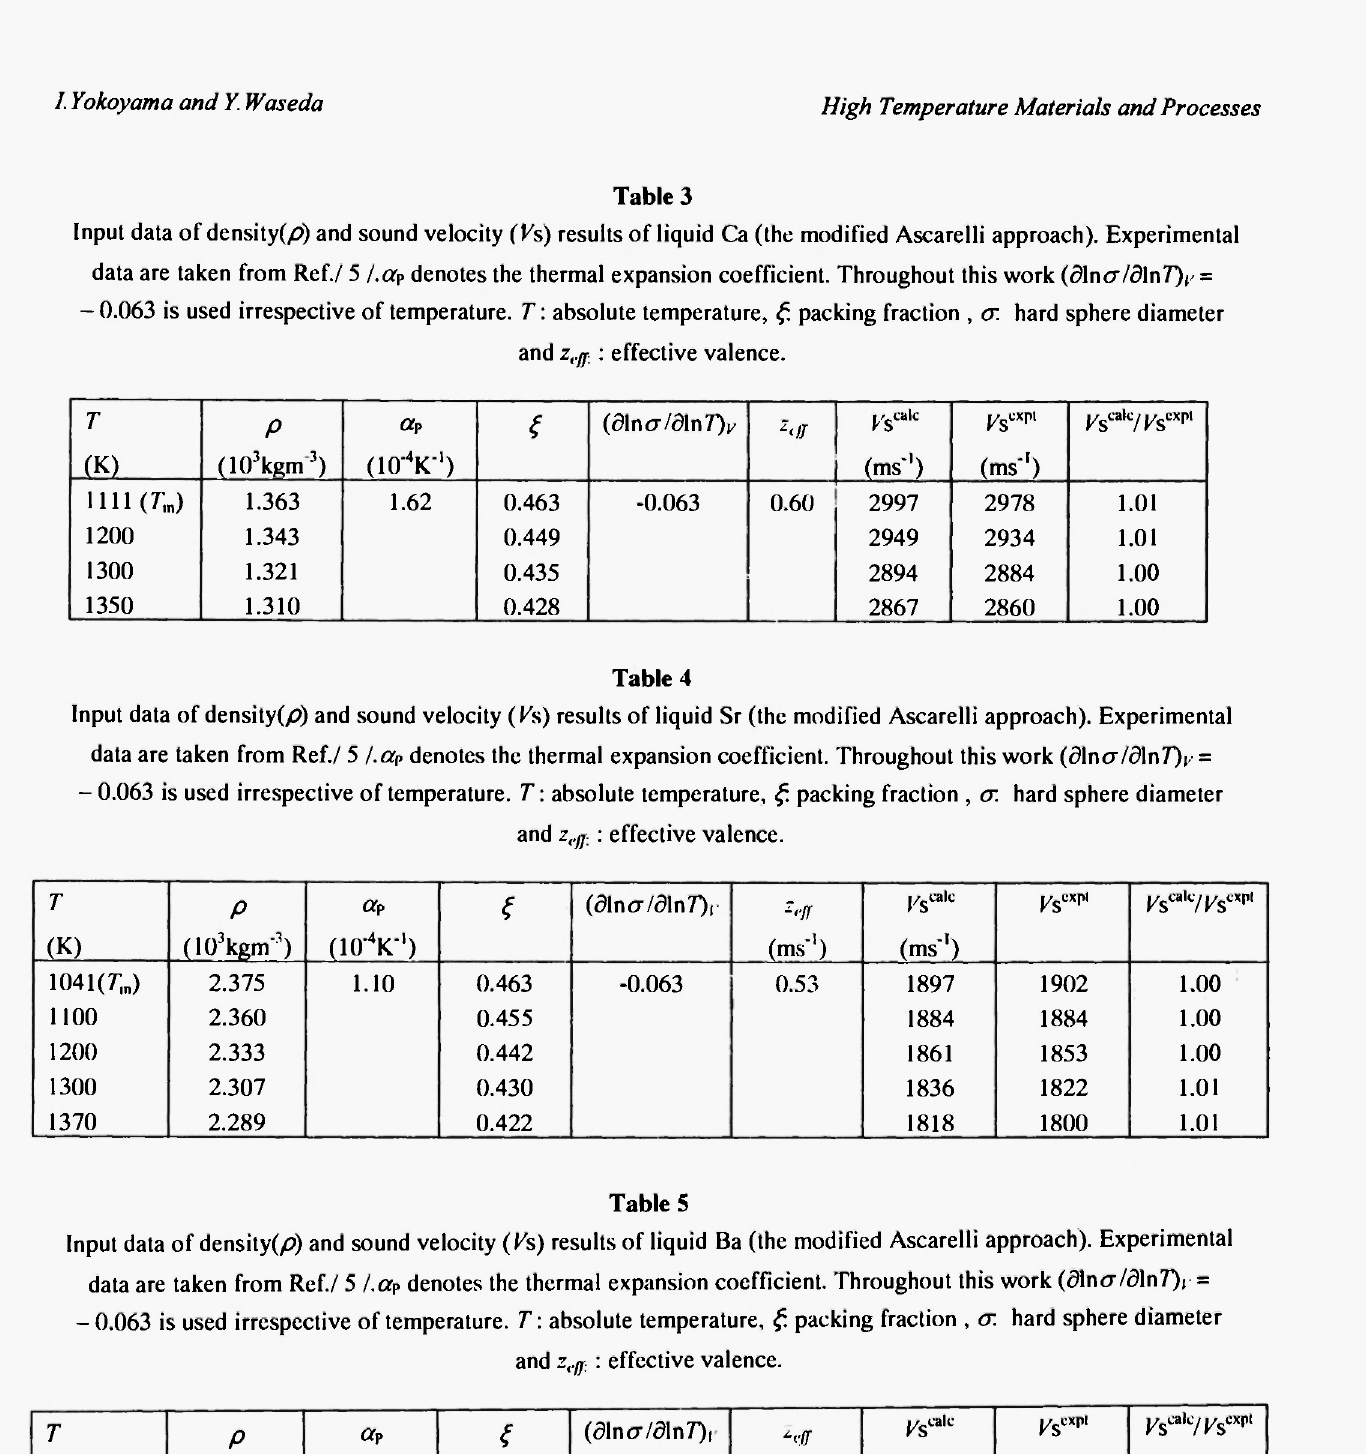
Input data of densityOo) and sound velocity (Ts) results of liquid Ca (the modified Ascarelli approach). Experimental data are taken from Ref./ 5 l.a P denotes the thermal expansion coefficient. Throughout this work (diner/δ1η7> = - 0.063 is used irrespective of temperature. Τ: absolute temperature, f packing fraction , σ. hard sphere diameter and z,.ff· \ effective valence.